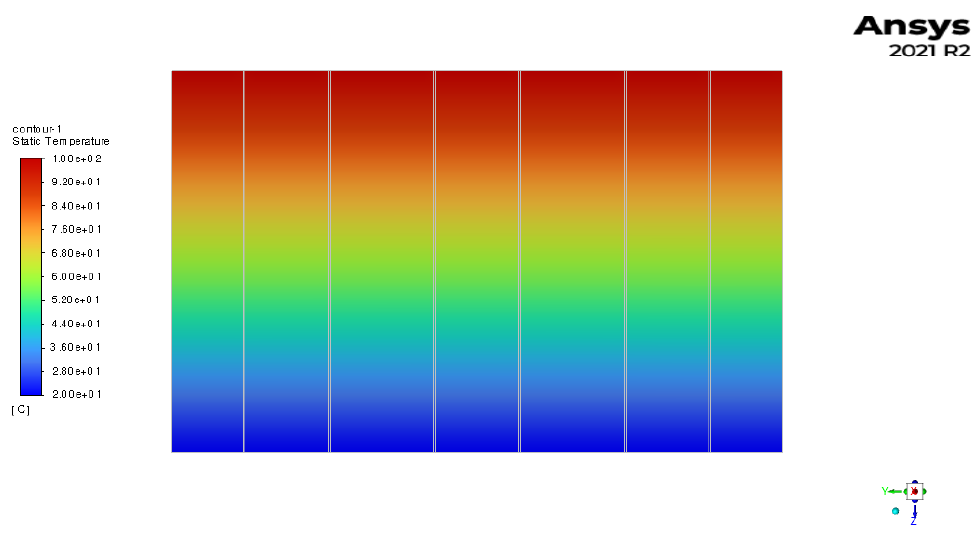
Figure 17. Schematic diagram of thermal conductivity measurement.